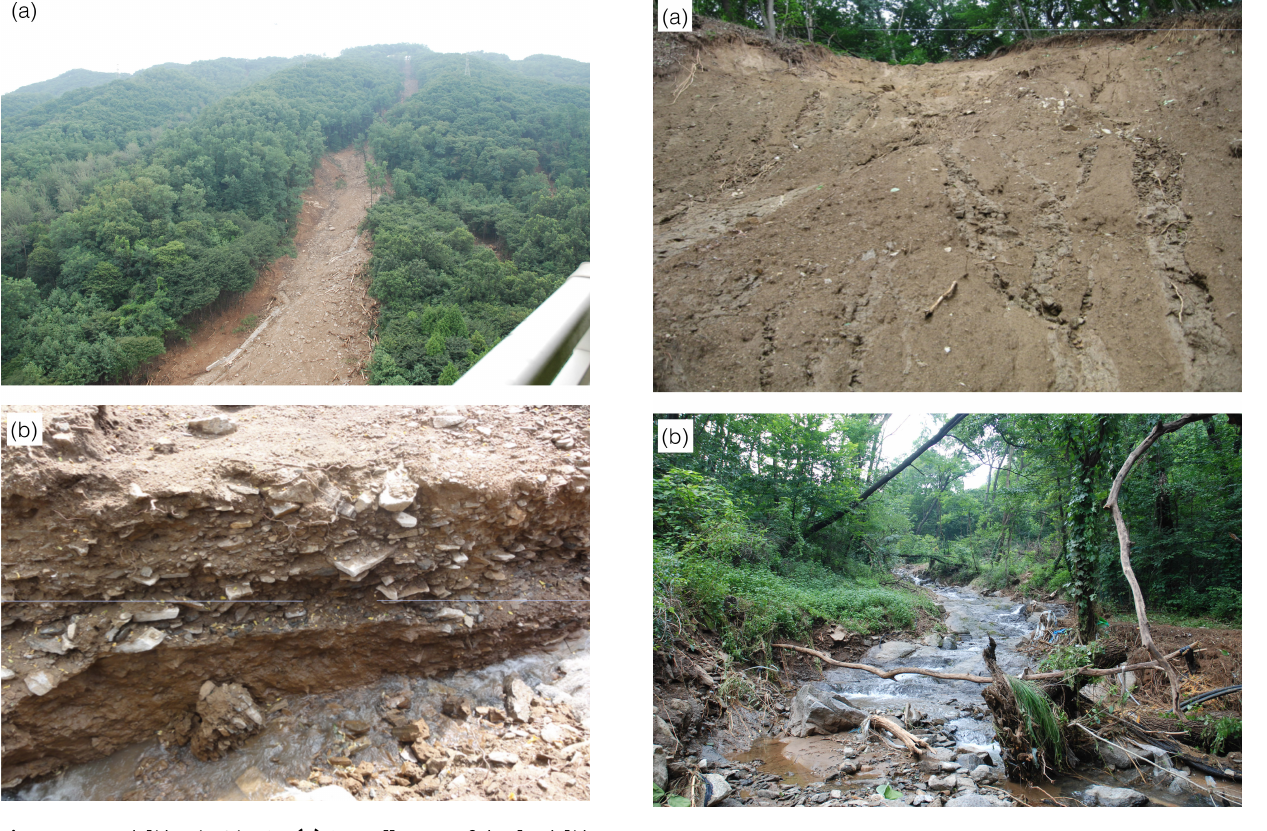
Figure 5. Landslides in Site B. (a) A closer look of the landslide initiation zone. A small volume of soil slid down along the smooth clayey surface which acts as a slickensided shear plane. (b) Up- stream valley where debris flows were traced, looking